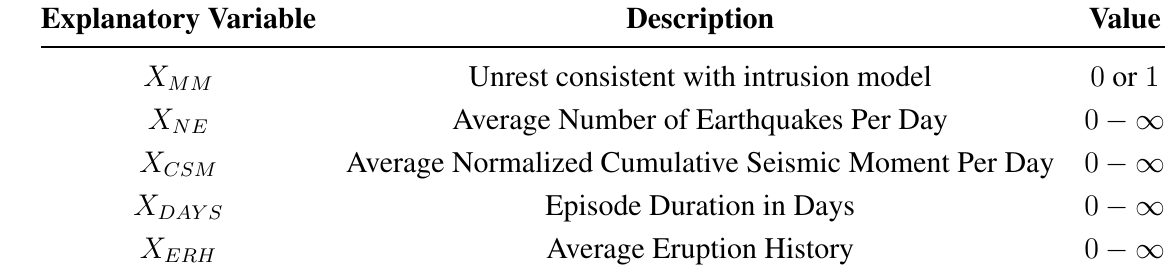
Logistic model explanatory variable names, descriptions, and possible range of